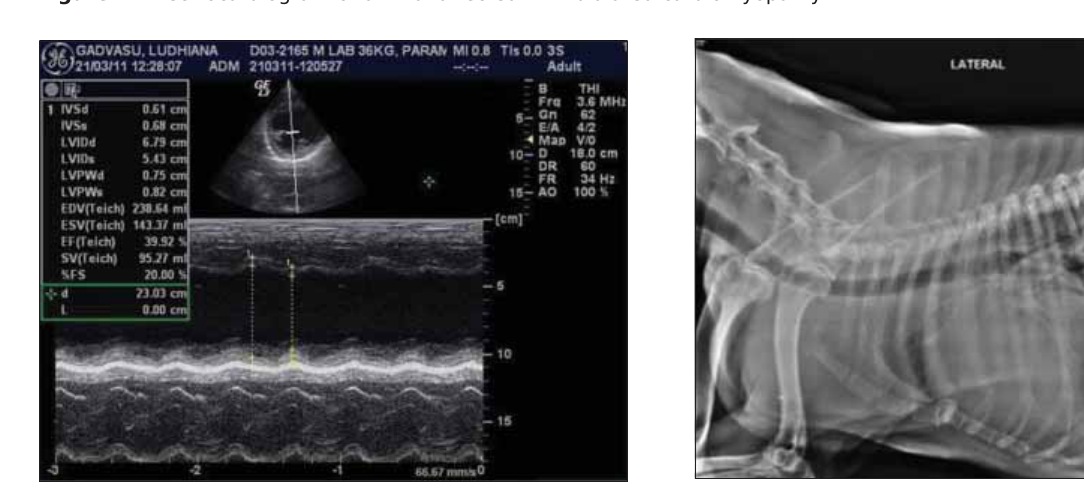
Figure-2: Electrocardiogram of animal affected with dialated cardiomyopathy.